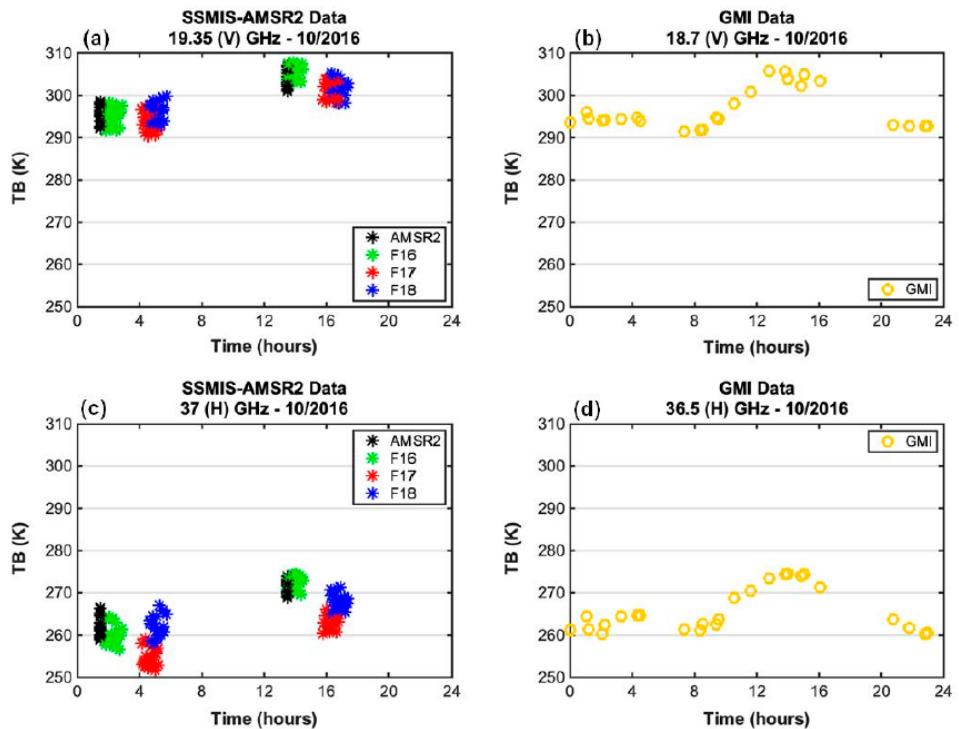
Figure 2. Satellite-borne passive microwave brightness temperature (PMW TB) observations at a sample location (17.4 ◦ N and 28 ◦ E) with non-vegetated desert land cover for October 2016 using ( a ) SSMIS F16, F17, F18, and AMSR2 at 19.35 GHz vertical polarization; ( b ) GMI at 18.7 GHz vertical polarization; ( c ) SSMIS F16, F17, F18, and AMSR2 at 37 GHz horizontal polarization; ( d ) GMI at 36.5 GHz horizontal polarization. Time in each subplot is in local solar